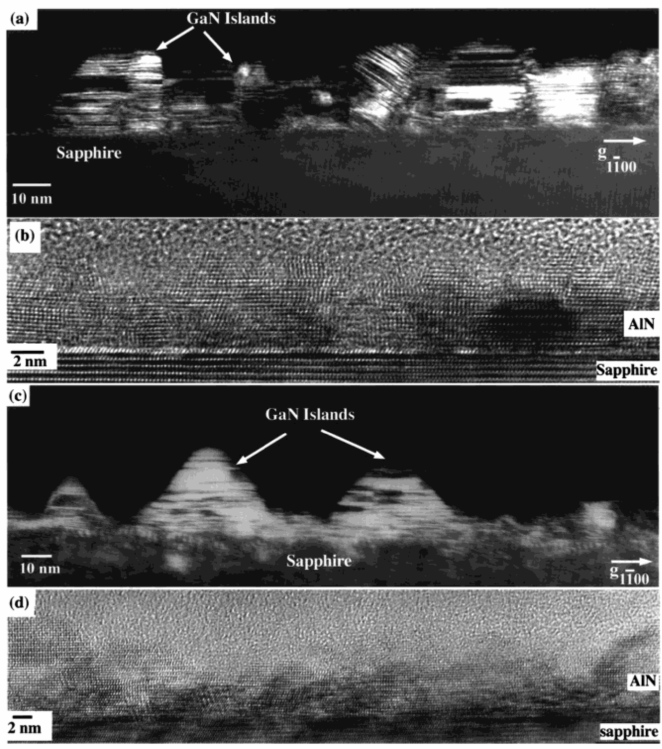
Figure 5. Cross-sectional TEM images of ( a ) GaN nucleation layer (NL); ( b ) AlN NL; ( c ) annealed GaN NL; ( d ) annealed AlN NL. For GaN NL, GaN 3D facet islands can be clearly observed before and after annealing. For AlN NL, however, no obvious AlN 3D islands can be observed. Reprinted from [41], with the permission of AIP